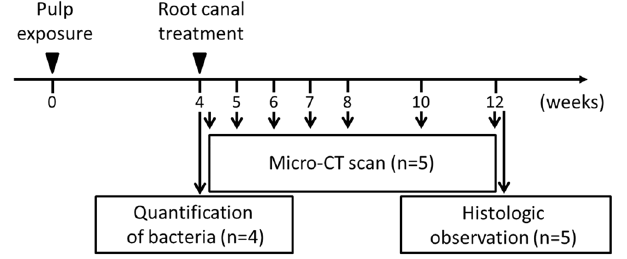
Figure 1. Experimental protocol. Root canal treatment was performed 4 weeks after pulp exposure and was evaluated by micro-CT scanning, quantification of bacteria, and histological